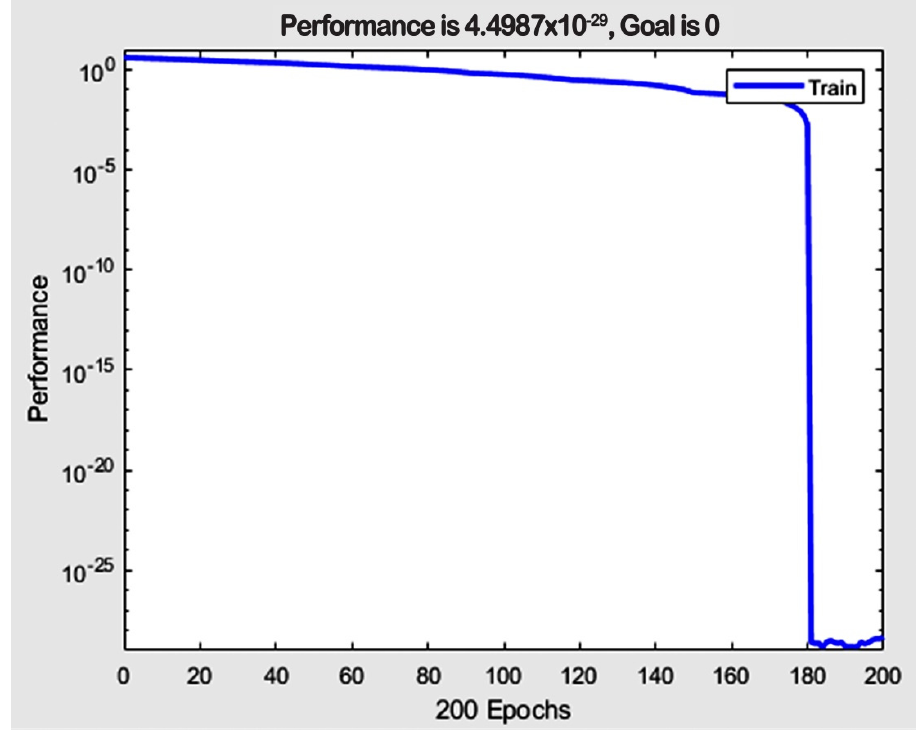
Figure 7. Performance of training for Duval_Triangle_1_RBFNN.